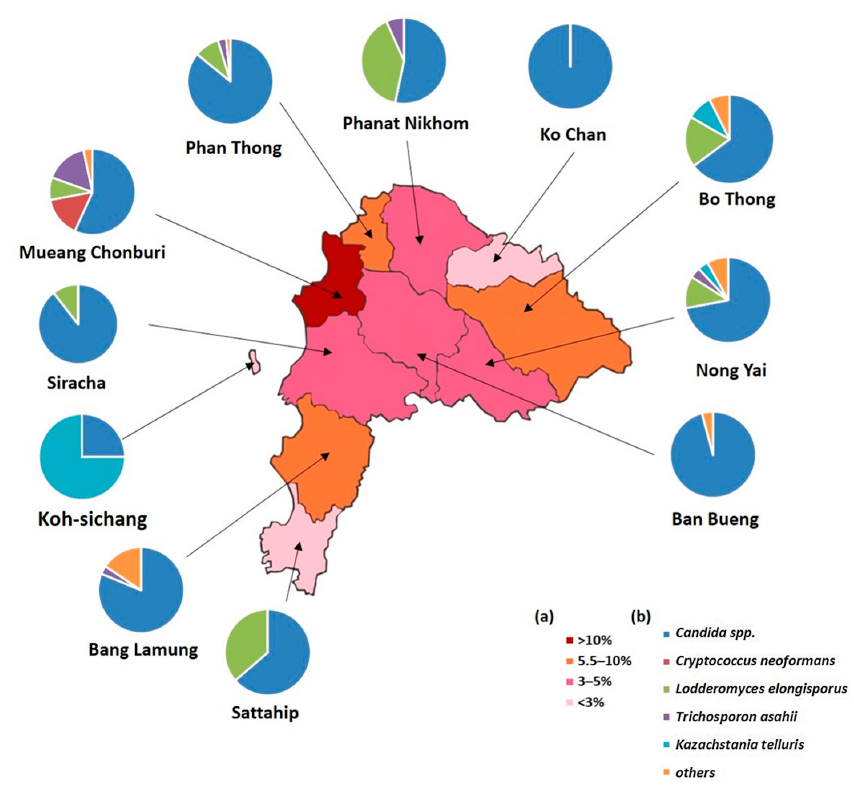
Figure 3. Map of Chon Buri province, Thailand: ( a ) percentage of pigeon excreta containing yeasts; ( b ) pie charts indicating the prevalence of yeast species found in pigeon excreta samples. Table 2. Summary of 147 yeast isolates differently identified by CHROMagar and by MALDI-TOF